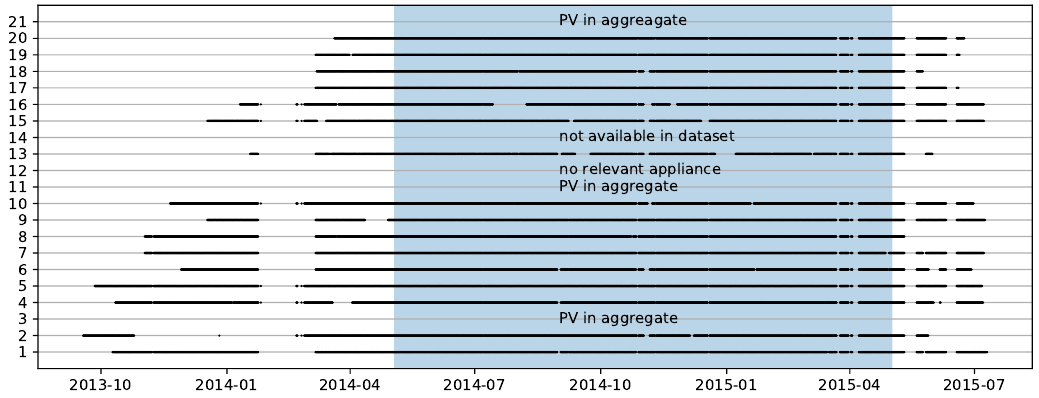
Figure 3. Data availability of the houses from REFIT dataset [18] selected for this study. Gaps in the lines correspond to periods where data were unavailable for more than a quarter day. The data range selected for this study is marked with a blue background. See text for details on excluded